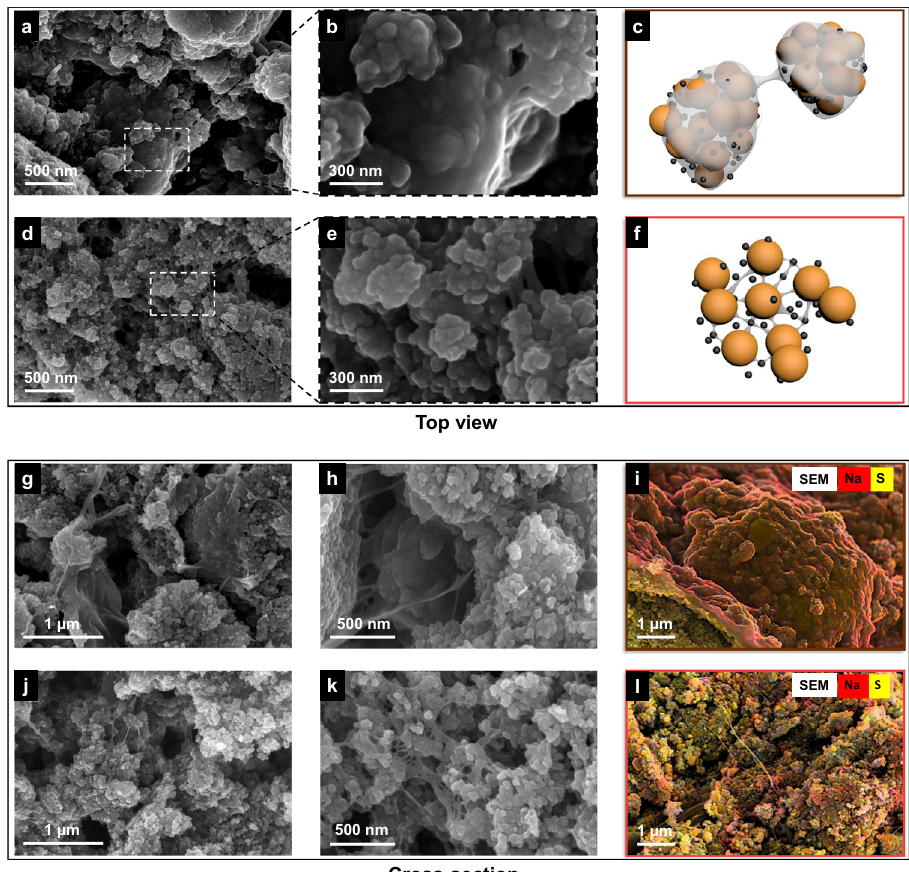
Fig. 4 Microstructural study, elemental mapping, and schematic illustration of the sulfur electrode with the different binder systems. Top-view SEM images and schematic illustration of the architecture in sulfur cathodes with different binders. a – c pure CMC as the binder, demonstrating a cohesive network of agglomerated particles being trapped in the network of the binder; d – f CMC/G as the binder, illustrating a segregated structure that separated particles linked by web-like binders. Cross-sectional SEM images and elemental mapping of cathodes with different binders. g – i pure CMC as the binder, demonstrating a continuous binder fi lm covering on the surface of particles; j – l CMC/G as the binder, illustrating the existence of bridging bonds across the electrode and excellent sulfur Fig. 4j to l provide evidence for the formation of web-like structure in the CMC/G cathode.